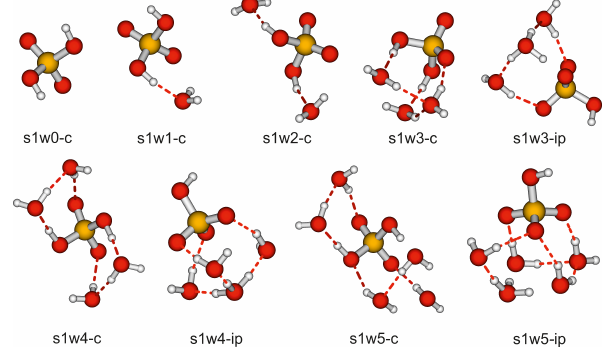
Figure 3. The observed most stable energy isomers of H 2 SO 4 (H 2 O) n ( n = 0–5) clusters with both hydrogen-bonded (H 2 SO 4 ··· H 2 O) (c) and ion-pair (HSO − optimized at the M06-2X/aug-cc-pVDZ level of